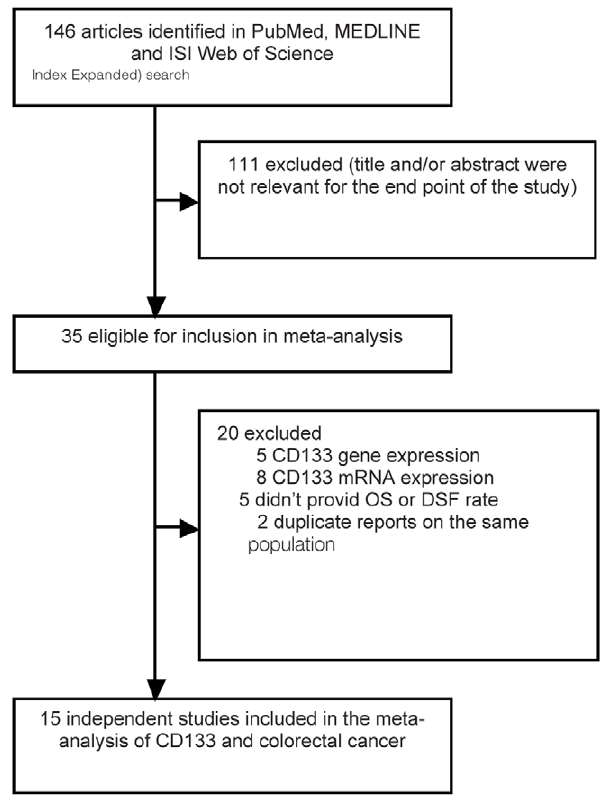
Figure 1. Flowchart of selection of studies for inclusion in